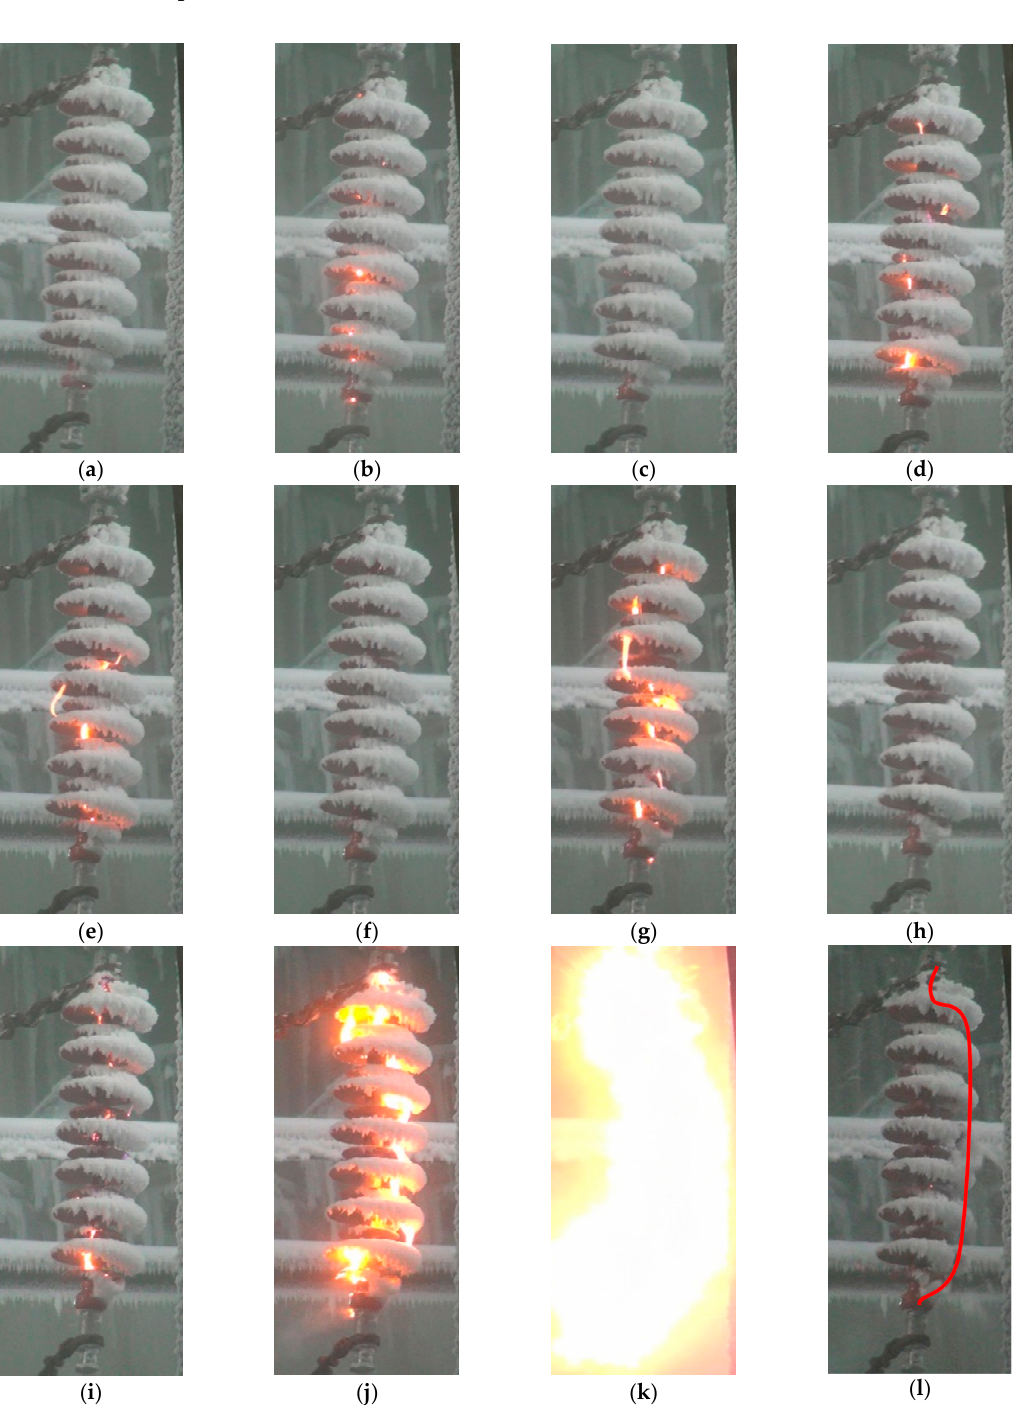
Figure 9. Flashover process of snow-covered FXBW-35/70. ( a ) t = 0; ( b ) t = 3.88 s; ( c ) t = 4.42 s; ( d ) t = 6.10 s; ( e ) t = 6.74 s; ( f ) t = 7.54 s; ( g ) t = 8.32 s; ( h ) t = 9.16 s; ( i ) t = 9.72 s; ( j ) t = 10.14 s; ( k ) t = 10.18